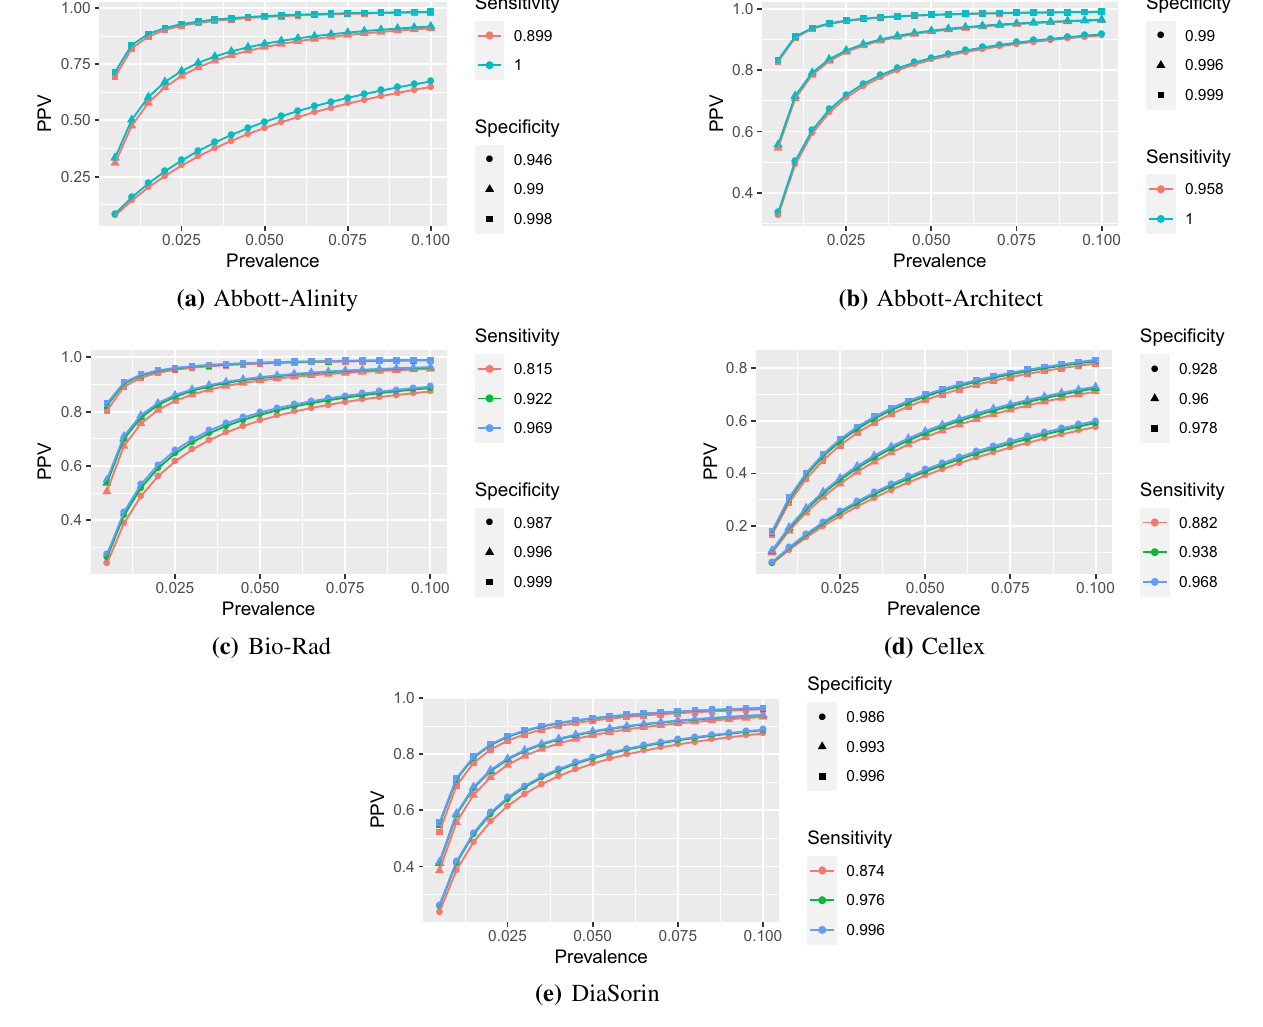
Figure 3. PPV by prevalence (up to 10%) for FDA tests ( a – d